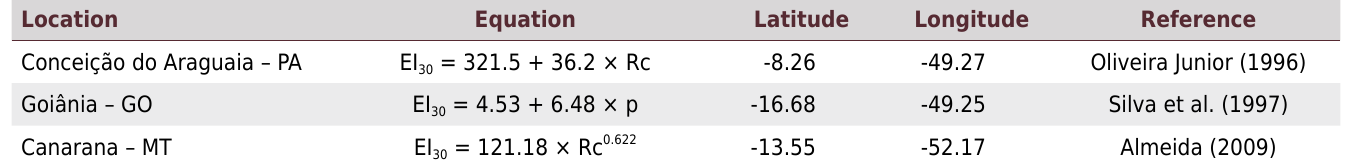
Table 1. Main equations available for the estimation of R-factor as a function of the Fournier’s index (Rc), and monthly average rainfall (p) in the proximity of the state of Tocantins